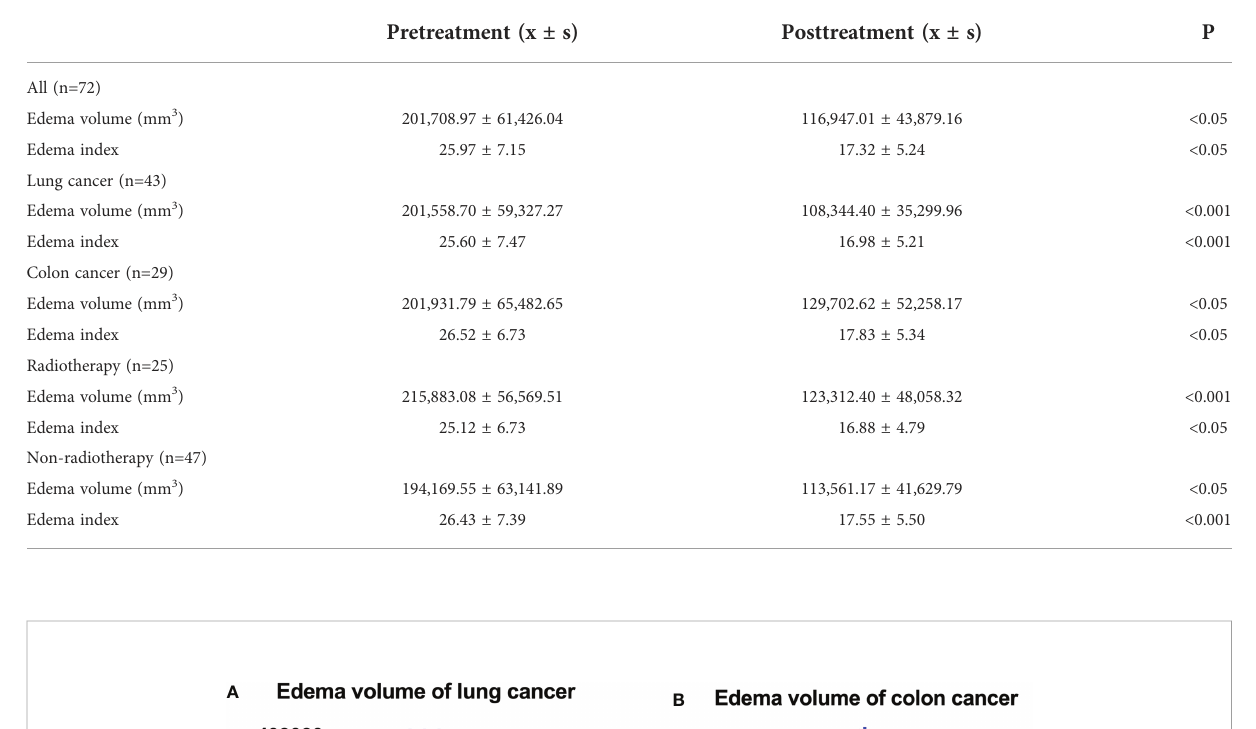
TABLE 2 Changes in edema volume and edema index after